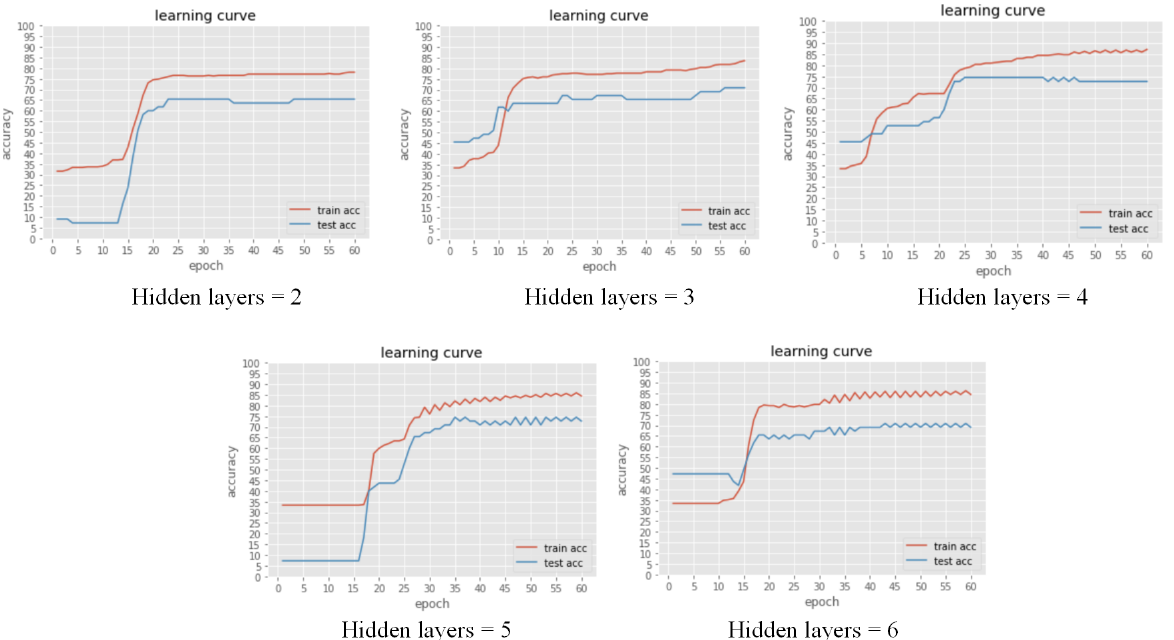
Figure 3. The accuracy of the train and test dataset under different hidden layers numbers (epoch = 60).